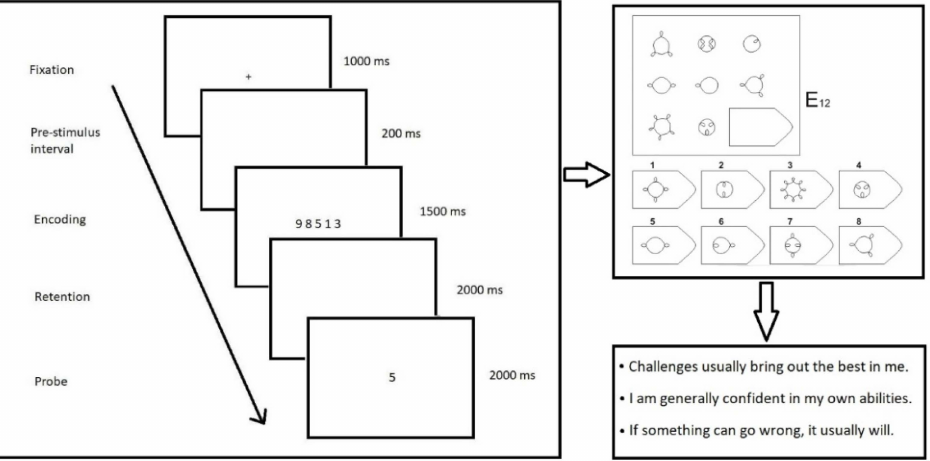
Figure 1. Research materials. ( Left panel ): Example of stimuli and presentation sequence for the Sternberg task. ( Right panels ): ( top )—example of the RSPM stimuli; ( bottom )—example of the MTQ48